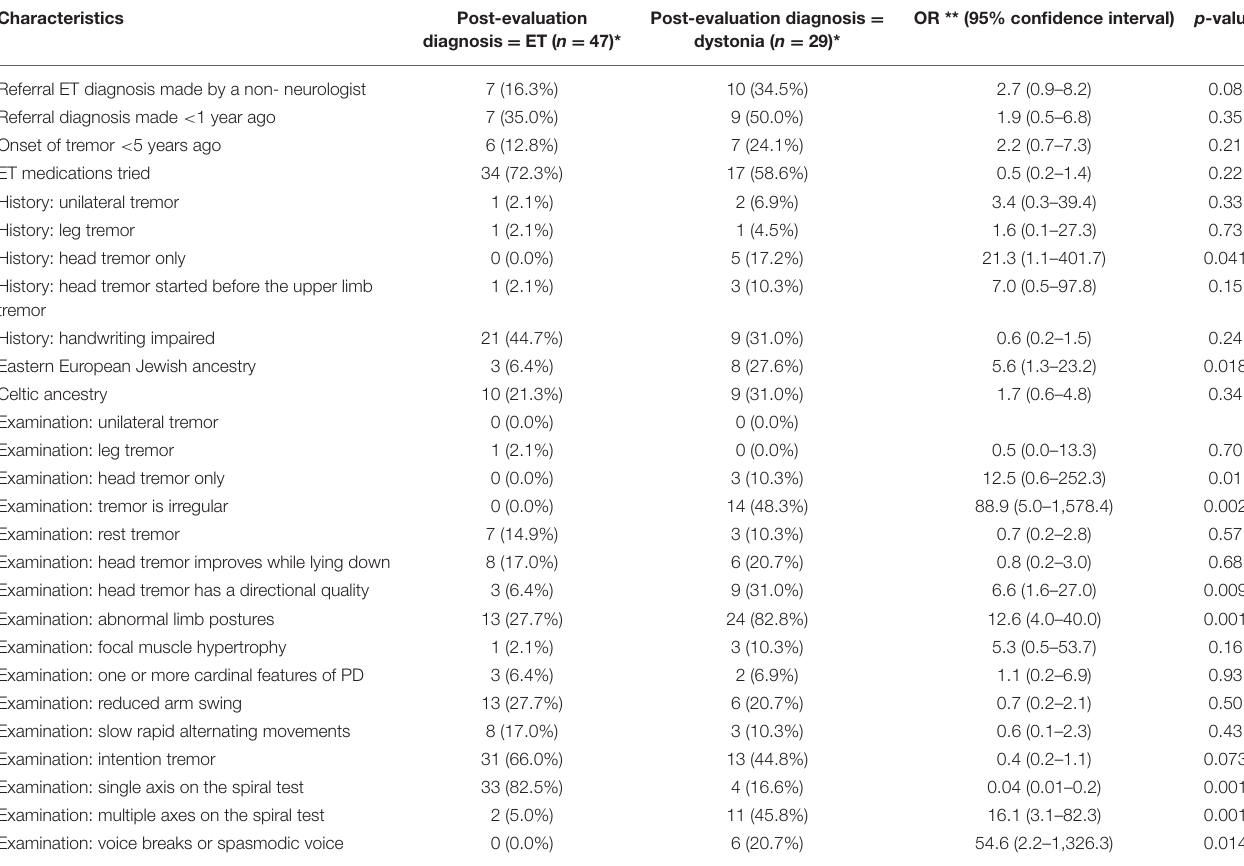
TABLE 4 | Additional clinical characteristics of 47 patients with a post-evaluation diagnosis of ET vs. 29 patients with a post-evaluation diagnosis of dystonia.